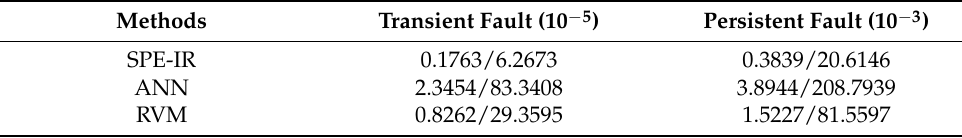
Table 9. Comparison of data recovery error (MAE/MAPE).